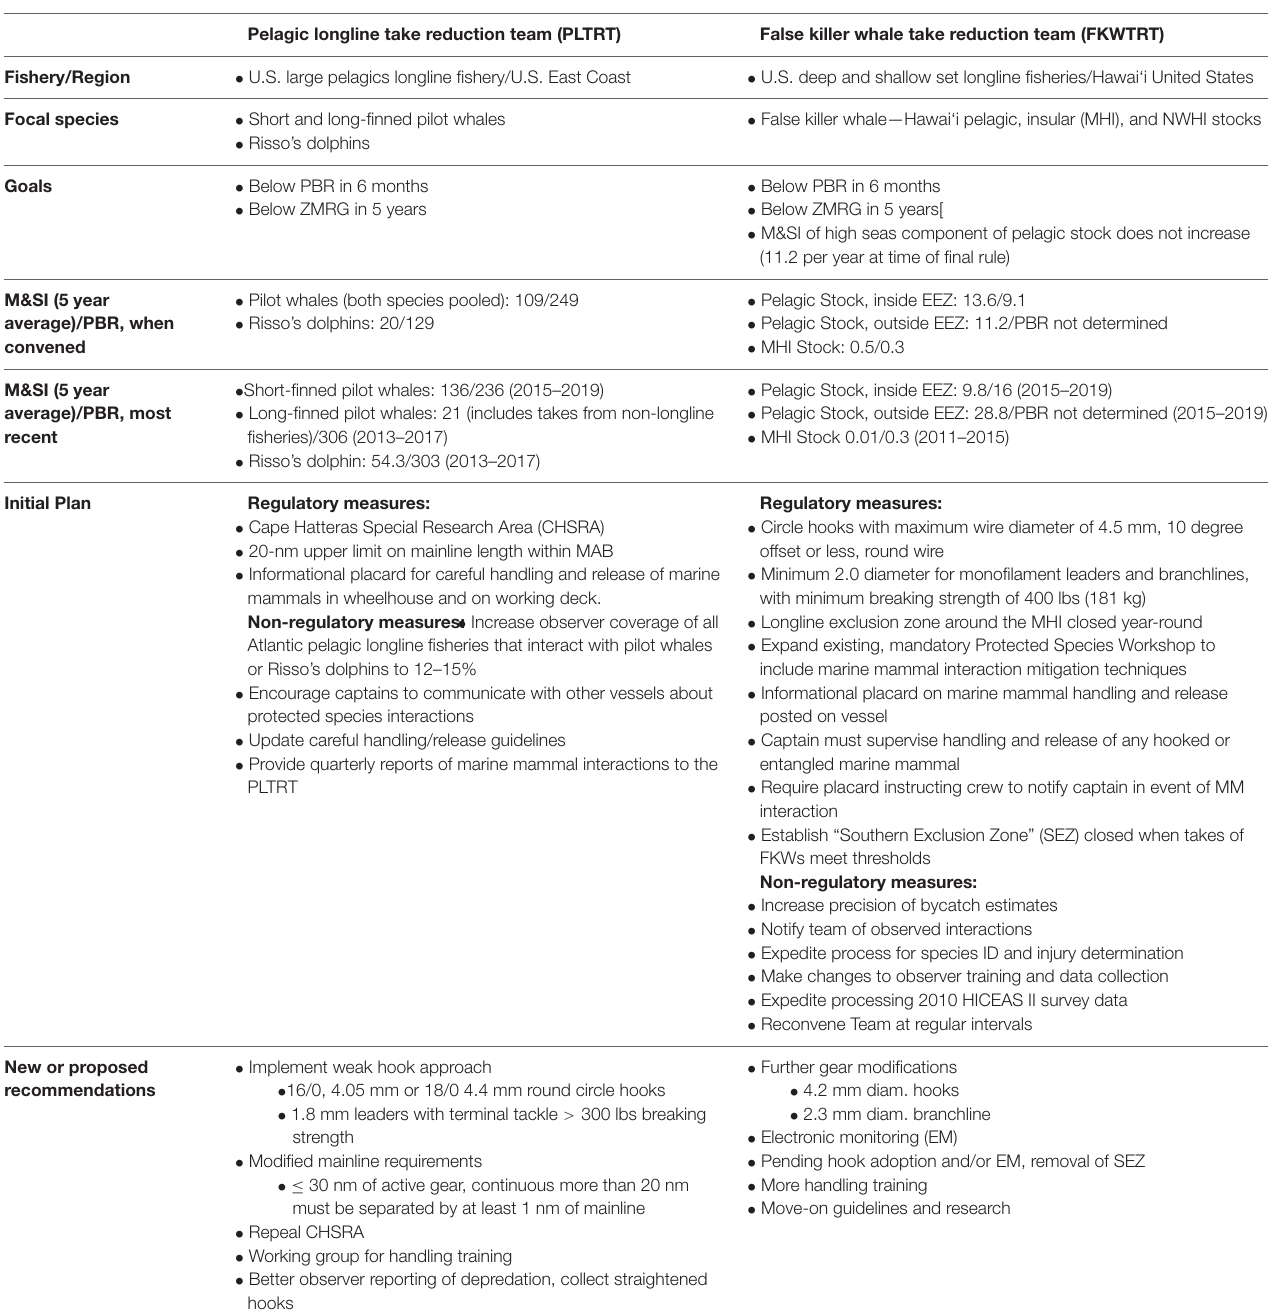
TABLE 1 | Outline of objectives and policy actions relevant to each